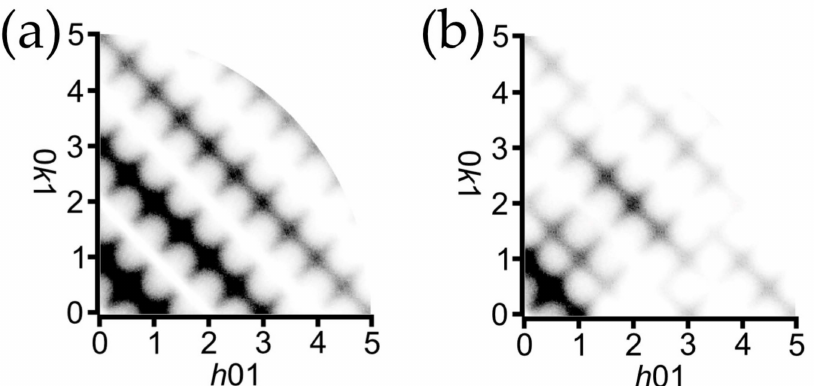
Figure 9. hk 1 plane calculated using structures obtained via Monte Carlo simulations: calculated including Cu atoms only ( a ); calculated including C atoms only ( b ). Intensities for C atoms enhanced 10 times with respect to the intensities for Cu